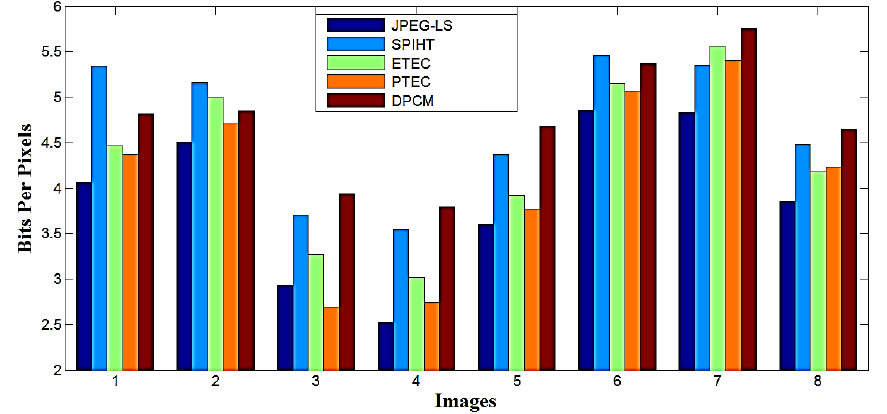
Figure 11. Comparison of bits per pixels for non-pixelated images.